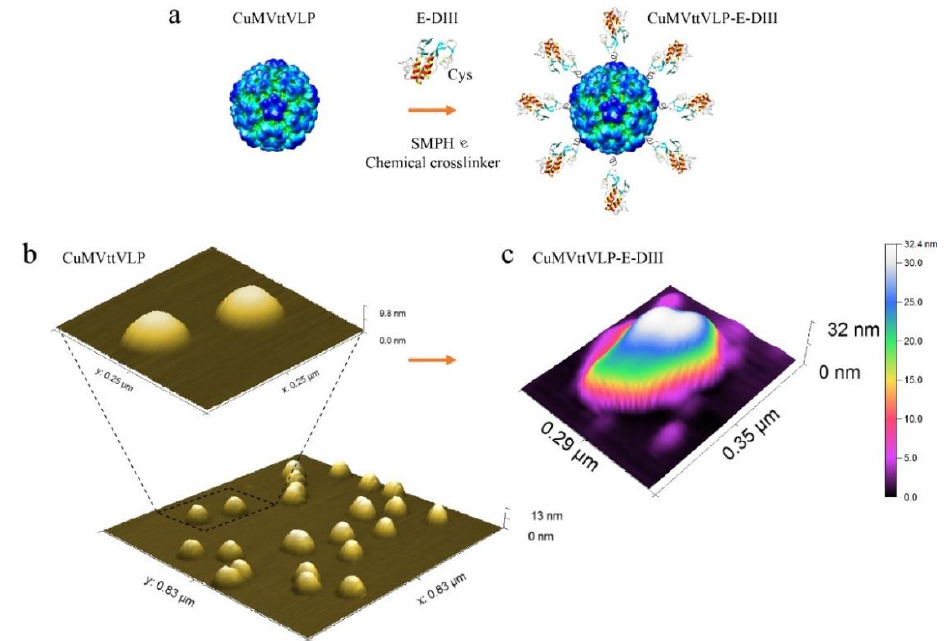
Figure 1. Summarizes the vaccine design and atomic force microscopy (AFM) images. ( a ) The conjugation of Zika virus E-DIII protein was done by modifying the CuMVttVLP with a chemical crosslinker (SMPH) and binding it to a modified protein with sulphydryl groups (-SH), as described in the Methods section “Vaccine formulation: coupling CuMVttVLP with E-DIII and mix with dioleoyl phosphatidylserine (DOPS)”. The AFM imaging was carried out by employing Nanosurf FlexAFM scan head (100 μm scan range) with C3000 controller using PPP-NCHAuD cantilevers (Nanosensors) in dynamic mode and processed using Gwyddion software. ( b ) Yellow samples show the CuMVVLP alone, without any protein attached, and ( c ) the following image shows a single particle with E-DIII proteins attached to it. The colour scale was adjusted to visually enhance smaller objects.